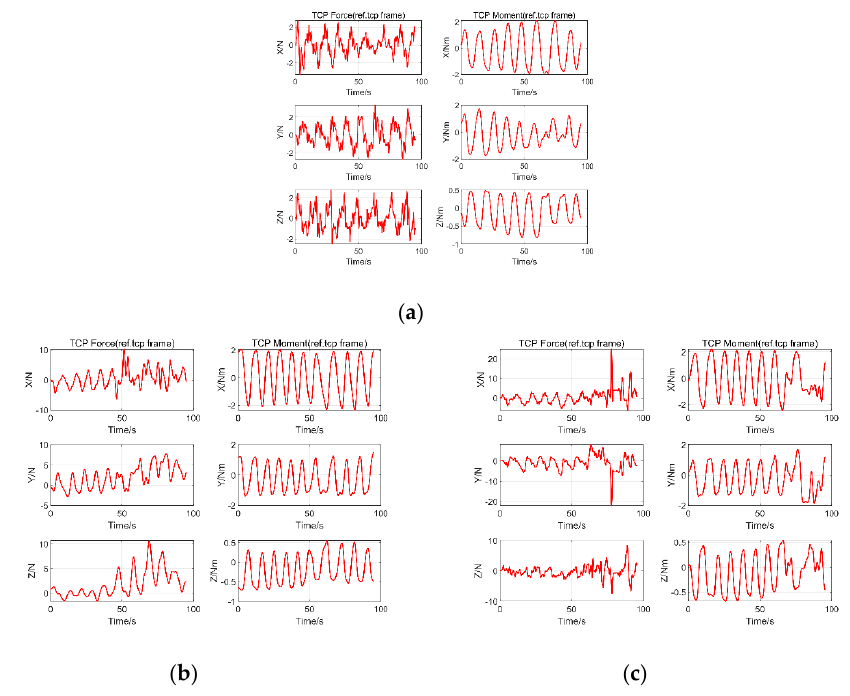
Figure 11. The interaction force between the robot and the subject’s hand during the three testing tasks. ( a ) the interaction force for task 1; ( b ) the interaction force for task 2; ( c ) the interaction force for task 3.